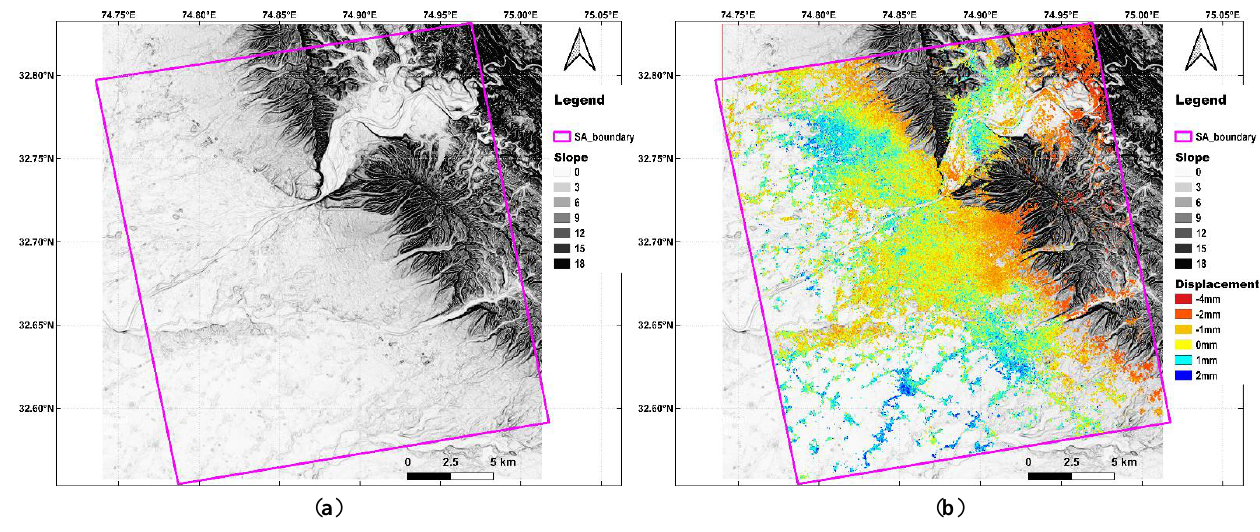
Figure 10. ( a ) The slope of the study area in degrees determined from the Copernicus 30 m DEM, ( b ) Overlay of the retrieved LOS displacement on ( a ).